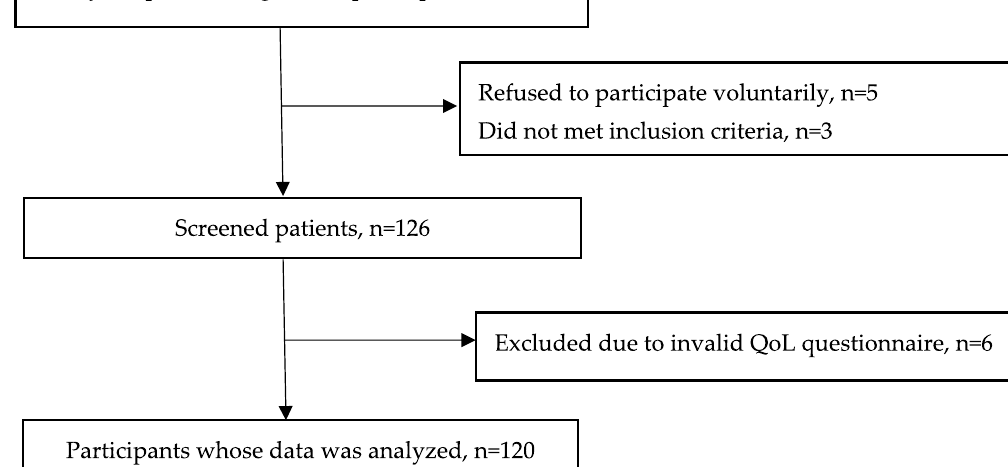
Figure 1. Flowchart of participants included in the